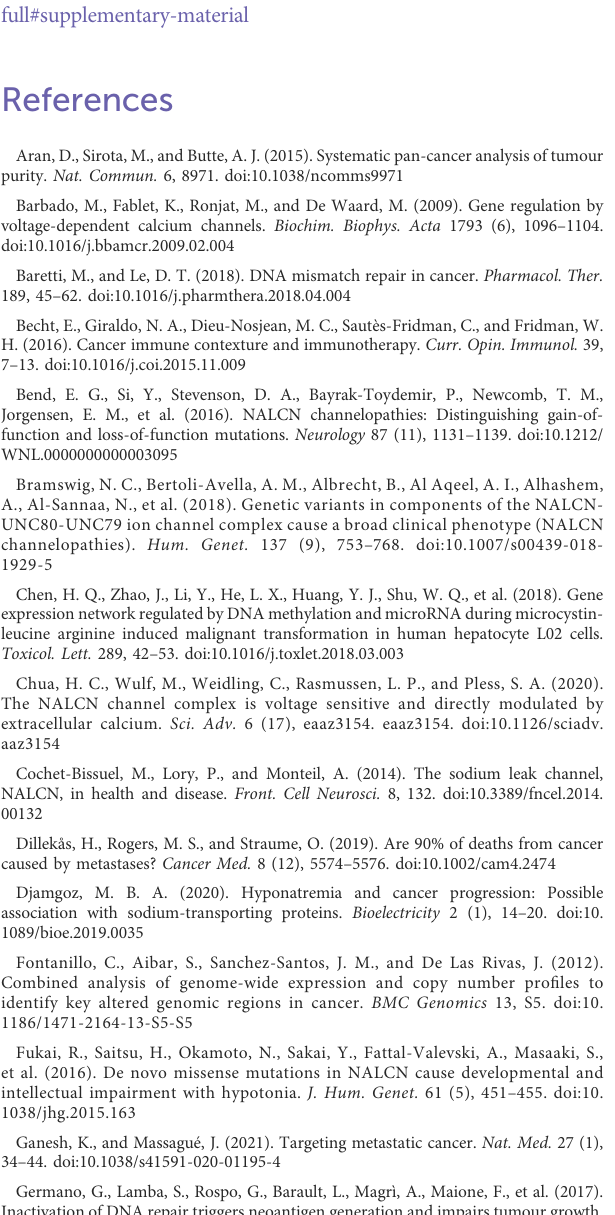
(STAD) patients with D704H/Y missense mutation. SUPPLEMENTARY TABLE S2 NALCN related gene list used for the enrichment